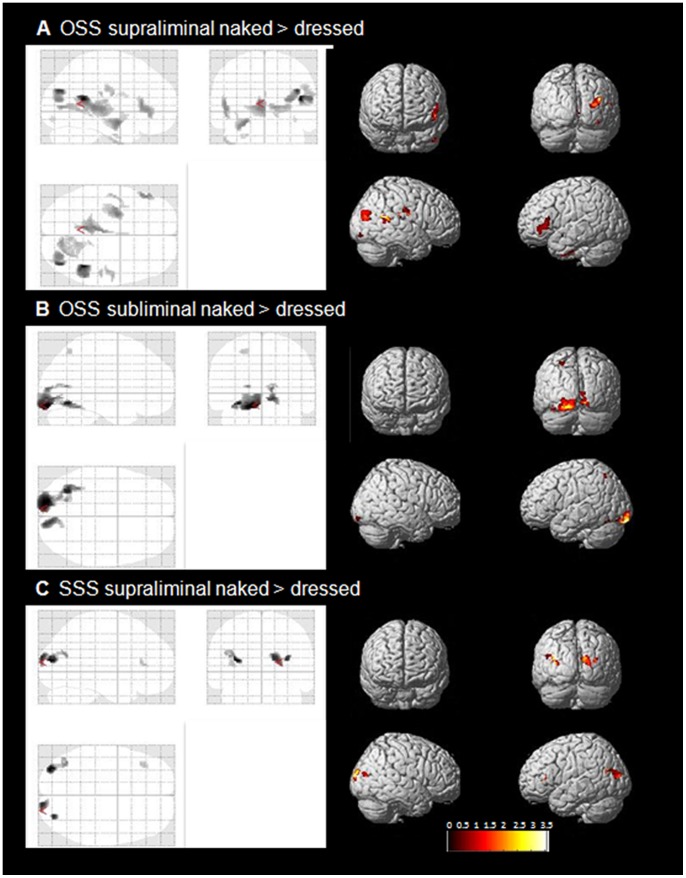
Inverse solution for the N1 component.Inverse solution on the basis of the N1 component estimated using the smooth prior inverse solution implemented in the statistical parametric mapping (SPM8) for the N1 component (146 ms–154 ms). Results show paired t-test for naked compared to dressed opposite/same-sex stimuli in the supraliminal and subliminal condition displayed on a glass brain (xjviewer). Statistical threshold p<0.5, cluster voxel size >15.